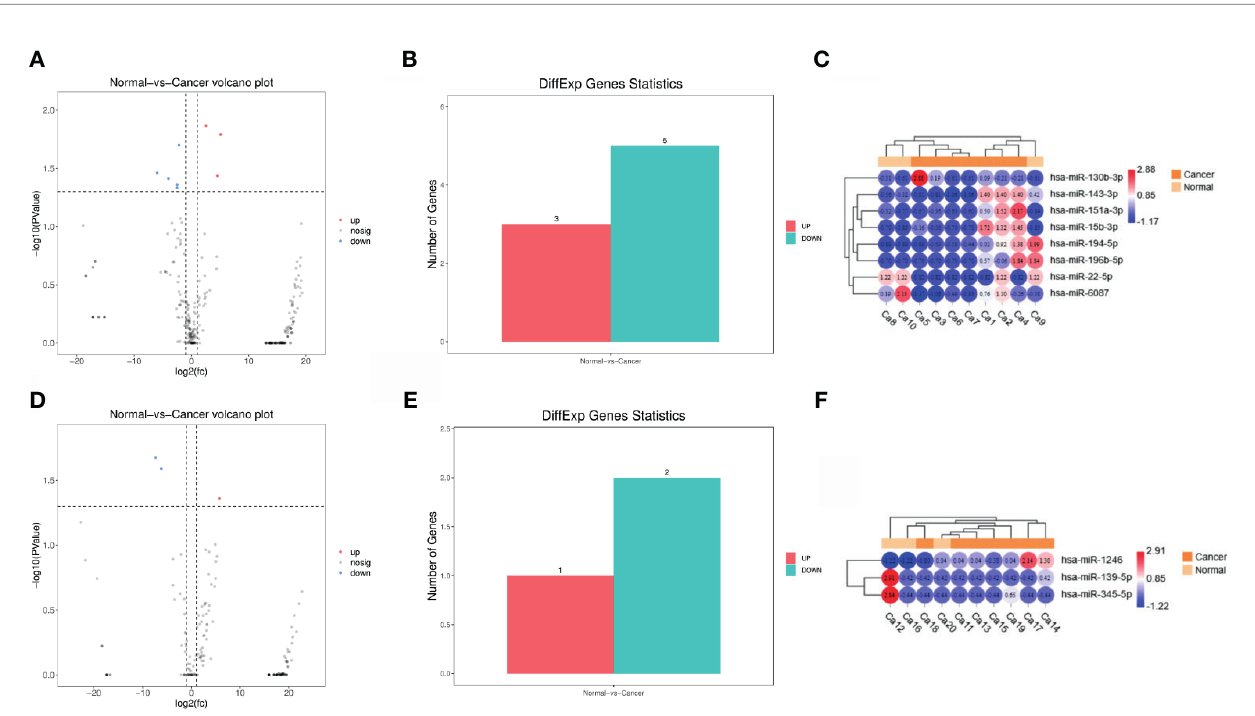
FIGURE 2 | Differentially expressed miRNA (DEmiRNAs) in plasma and urine samples of the gastric cancer (GC) patients. (A) The volcano plots of DEmiRNAs in serum. (B) Signi fi cant ups and downs in serum. (C) Expression heatmap of signi fi cantly expressed miRNAs in serum. (D – F) Urine.